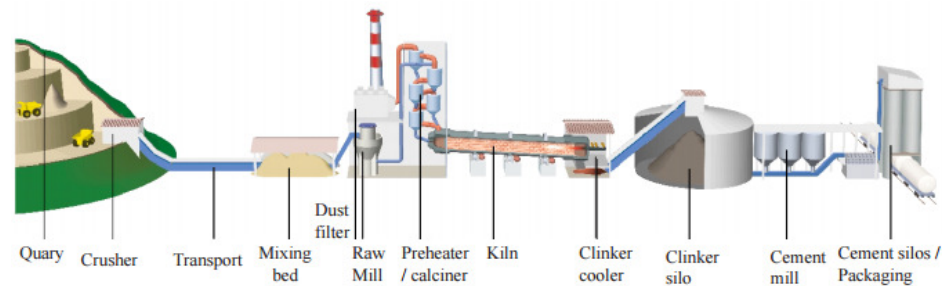
Fig. 1. General layout of the cement plant [1].